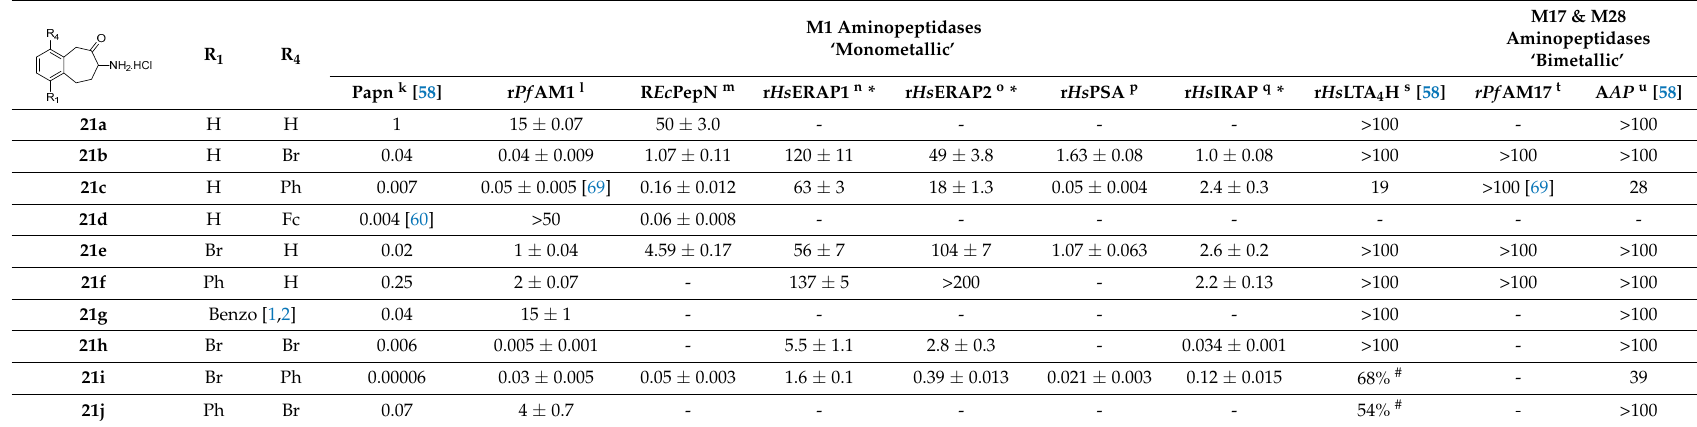
Table 4. Inhibition of selected aminopeptidases by racemic substituted 7-amino-5,7,8,9-tetrahydrobenzocyclohepten-6-one hydrochloride salts.